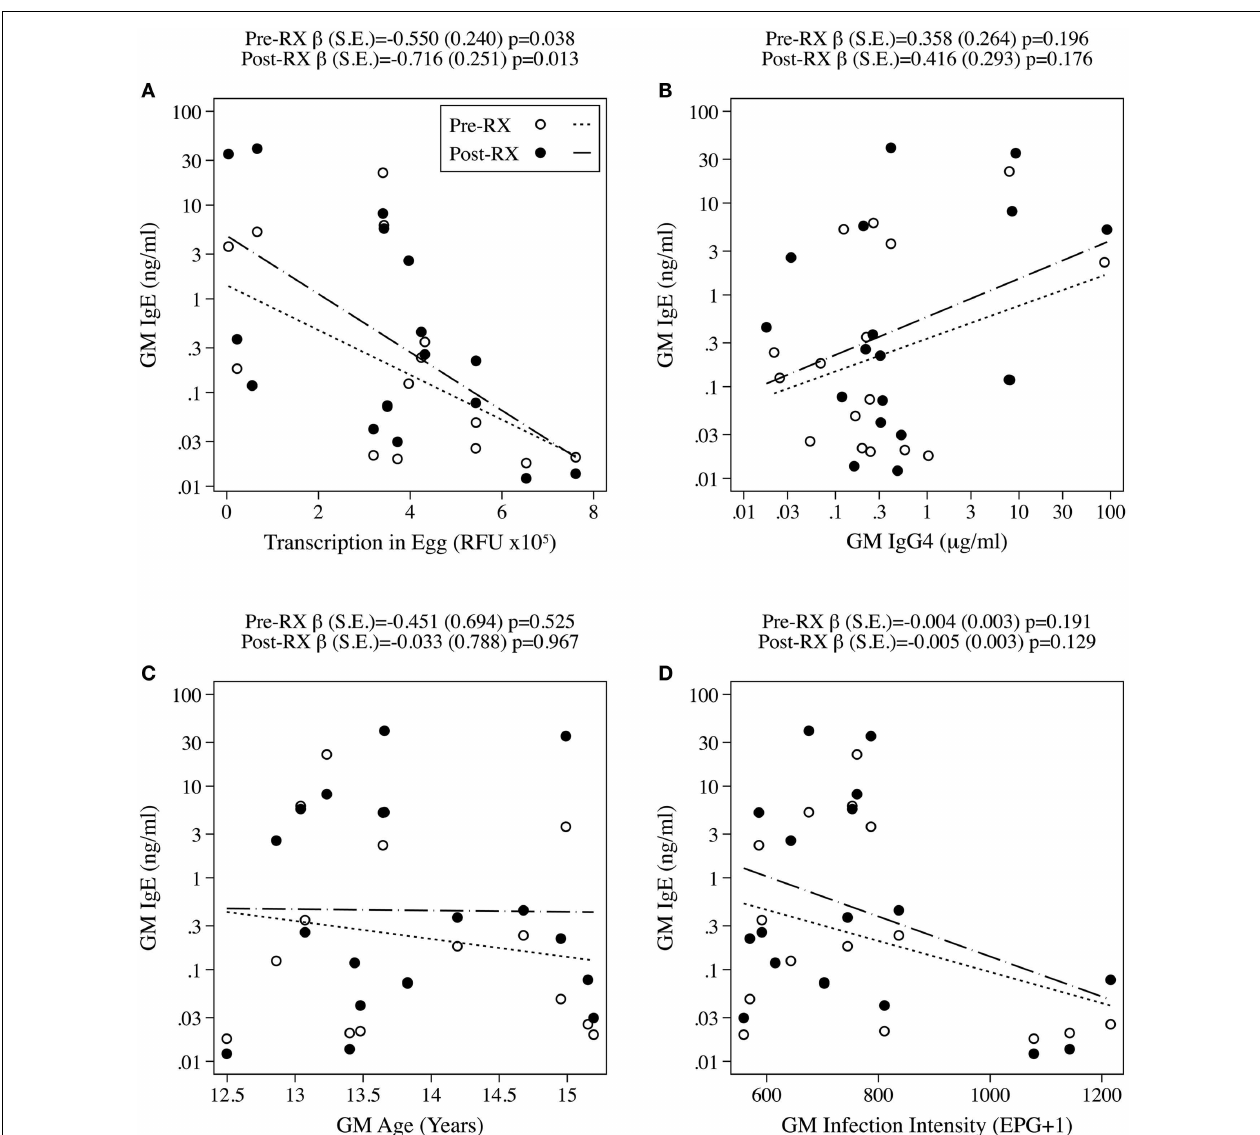
FIGURE 6 | Relationships between antigen-specific natural log normalized geometric mean (GM) IgE levels and transcription of antigen in egg (A)*, natural log normalized GM IgG4 levels (B), GM age (C), or GM infection intensity (D) in individuals that respond to either IgG4 or IgE